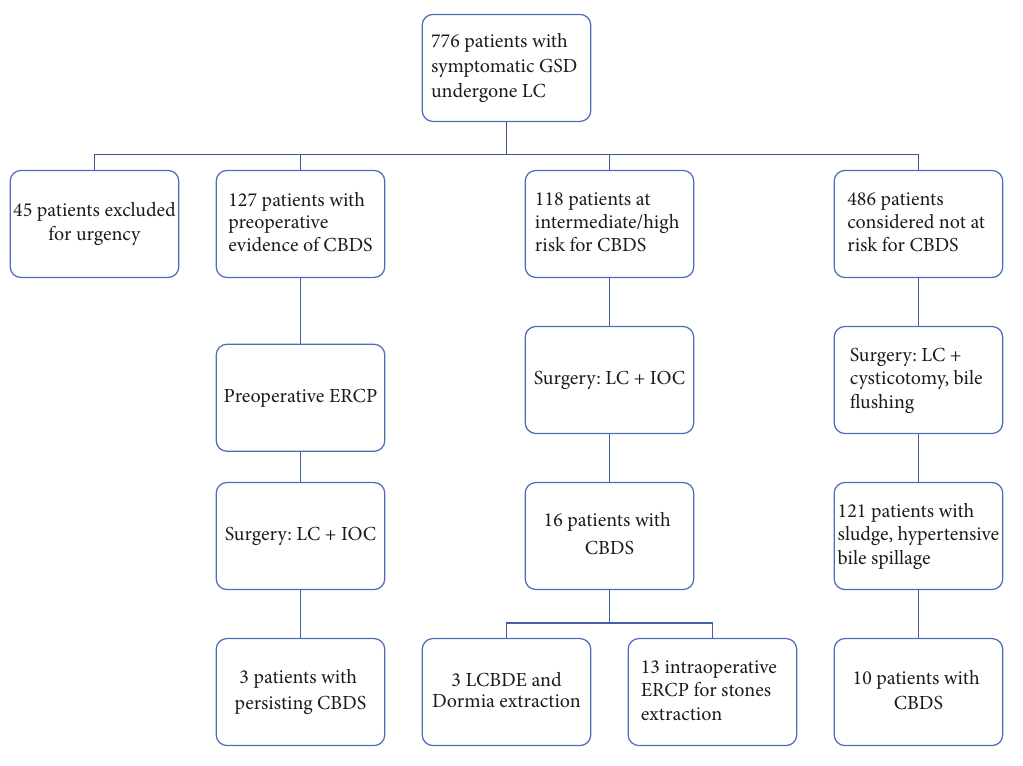
Figure 8: Flow-chart: population